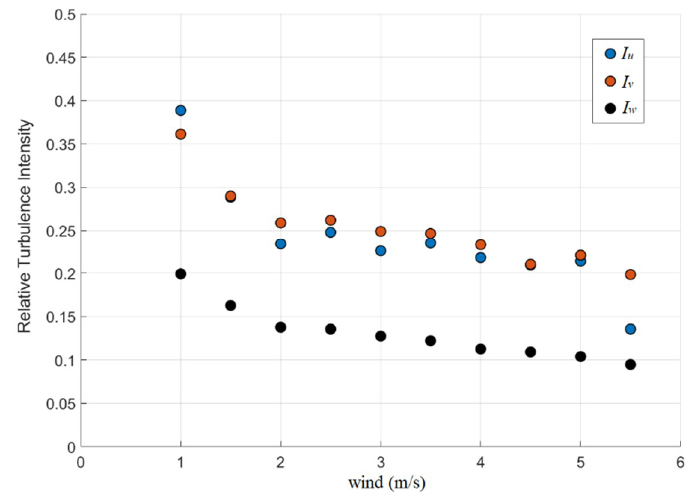
Figure 5. Relative turbulence intensity for the three Cartesian directions for each wind class, measured by a 3D sonic anemometer at the Nafferton (U.K.) field test site.